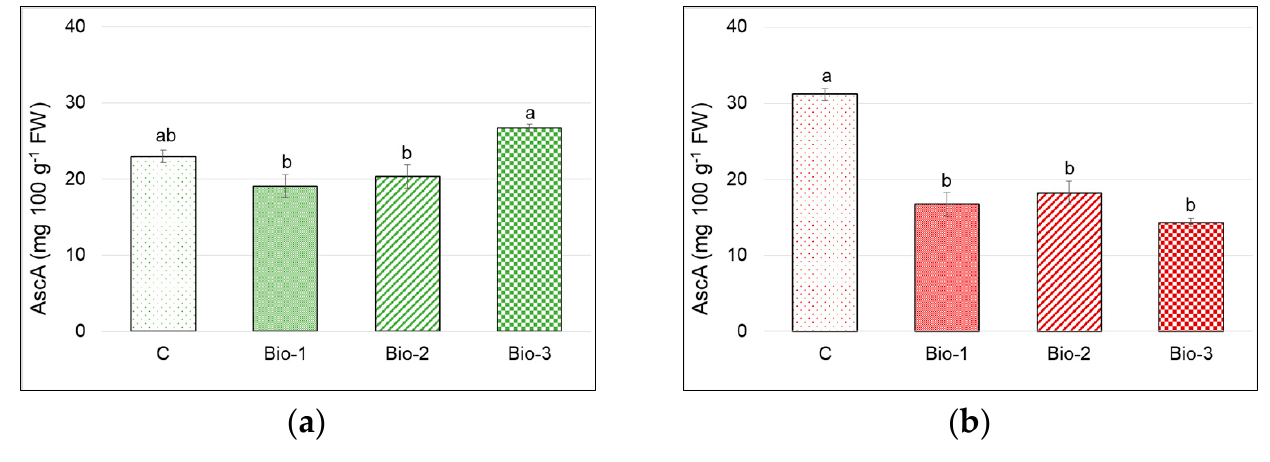
Figure 6. Effect of biostimulants (Bio-1 = TRAINER ® ; Bio-2 = AQUAMIN, and Bio-3 = Moringa oleifera leaf extract) on the ascorbic acid content (mg 100 g − 1 FW) in turnip greens ( a ) and radish ( b ) microgreens. Data are means ± se ( n = 3). Different letters indicate significance at p ≤ 0.05 according to the LSD test.